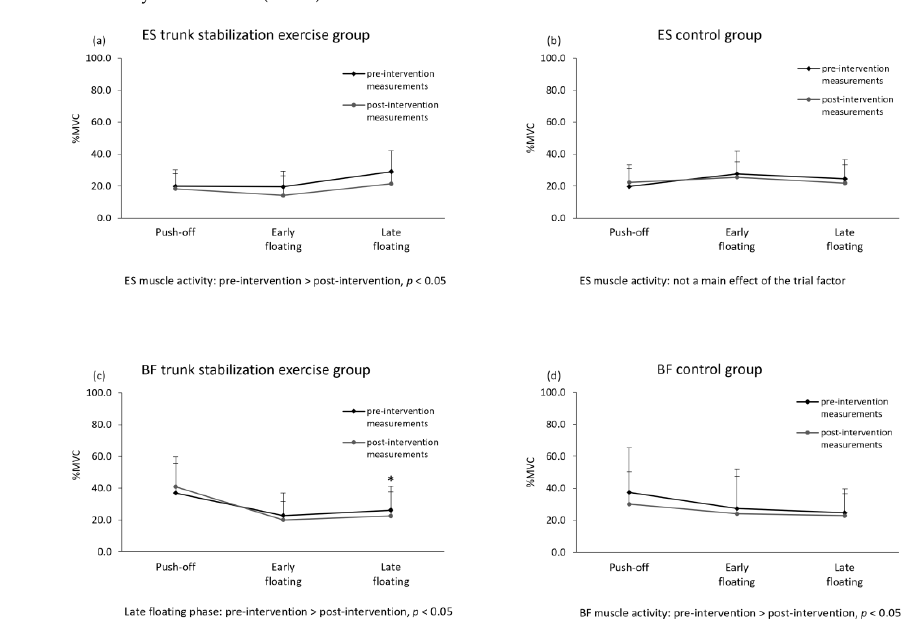
Figure 5. Comparison of pre- and post-intervention muscle activities. Abbreviations: ES — erector spinae; BF — biceps femoris; MVC — maximum voluntary contraction. ( a ) ES trunk stabilization exercise group; ( b ) ES control group; ( c ) BF trunk stabilization exercise group; ( d ) BF control group. Table 1. Baseline characteristics of the trunk stabilization exercise group and control group.